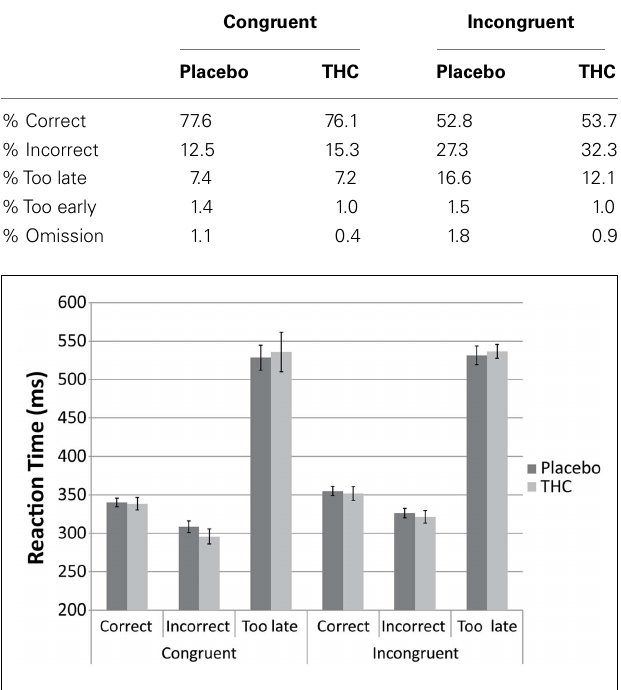
FIGURE 1 | Bar graphs showing average ReactionTime for “congruent” and “incongruent” trials for placebo (black), andTHC (gray) condition. Results are displayed separately for “correct,” “incorrect,” and “too late” responses. Error bars represent SE of the